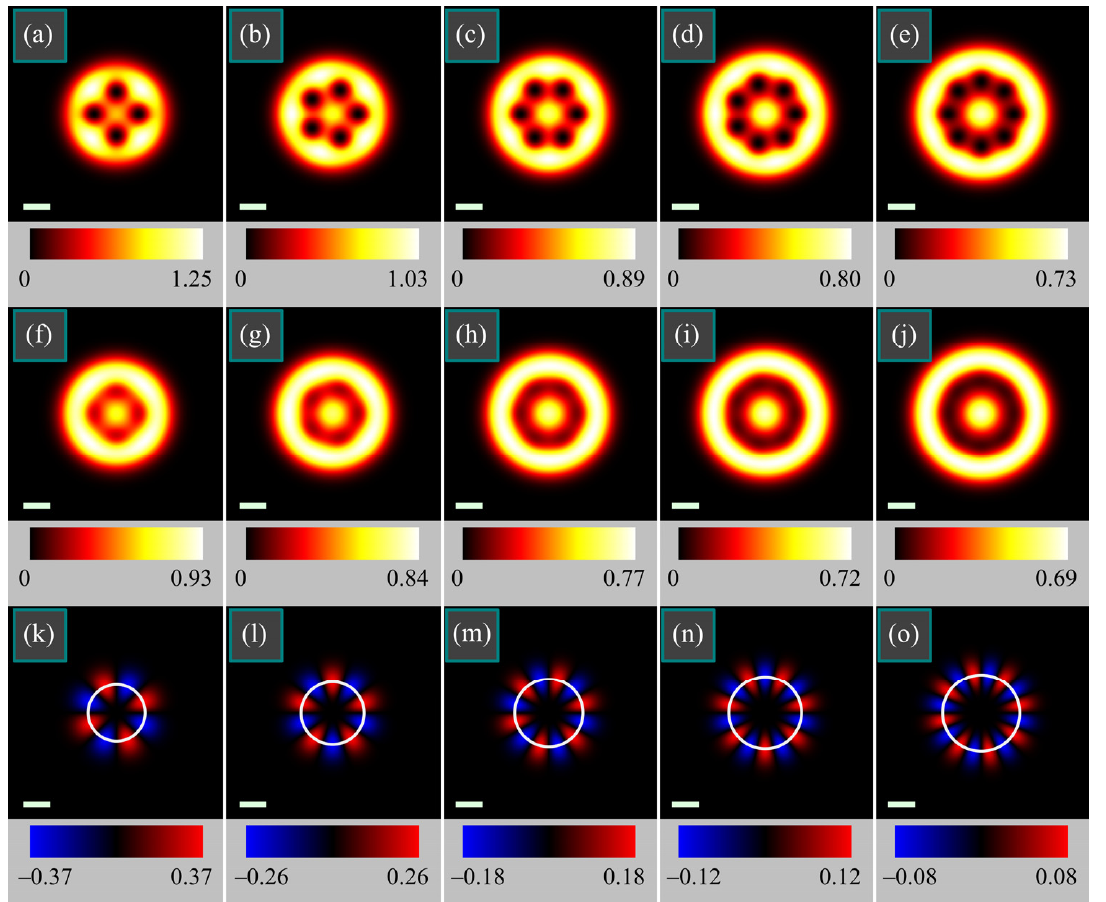
Figure 6. Intensity distributions in the initial plane ( a – e ) and at the maximal-SAM distance (33) ( f – j ), as well as SAM density distributions at the maximal-SAM distance ( k – o ) for the following parameters: wavelength λ = 532 nm, Gaussian beam waist radius w 0 = 1 mm, number of the polarization singularities in the initial plane m = 4 ( a , f , k ), m = 5 ( b , g , l ), m = 6 ( c , h , m ), m = 7 ( d , i , n ), m = 8 ( e , j , o ), radius of the singularities circle a 0 = 828 µ m ( a , f , k ), a 0 = 942 µ m ( b , g , l ), a 0 = 1041 µ m ( c , h , m ), a 0 = 1129 µ m ( d , i , n ), a 0 = 1210 µ m ( e , j , o ), propagation distance is z = 0.349 z 0 ( a , f , k ), z = 0.284 z 0 ( b , g , l ), z = 0.240 z 0 ( c , h , m ), z = 0.208 z 0 ( d , i , n ), z = 0.183 z 0 ( e , j , o ). The radii a 0 were computed by Equation (19) to equalize the intensities in the center and in the periphery. Circles on the SAM distributions ( k – o ) show the maximal-SAM radii obtained by Equation (25). All quantities (maximal intensity and SAM magnitude) are given in arbitrary units. Scale mark in each figure denotes 1 mm.